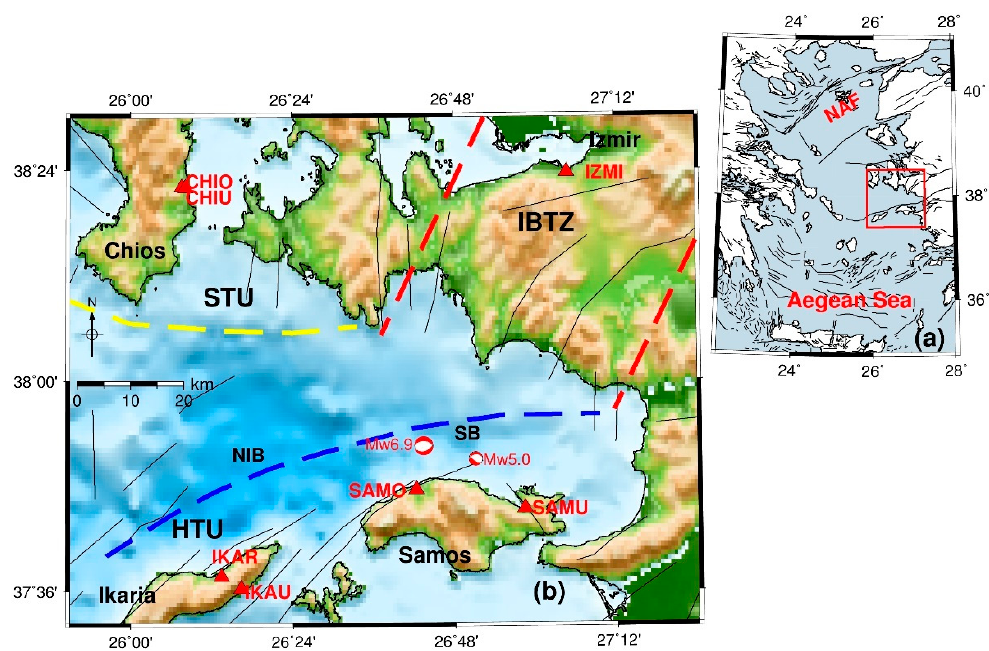
Figure 1. ( a ) Index map and ( b ) relief map of the broader area of Samos, which shows the location of continuous Global Navigation Satellite System (GNSS) sites that were used in this study (red triangles), together with the focal mechanism solutions of the Mw6.9 earthquake and its major aftershock. Faults (black lines) were taken from [15–18]. Red dashed lines define the Izmir Balikesir Transfer Zone (IBTZ); yellow dashed line marks the Sakarya Tectonic Unit (STU); blue dashed line defines the Hellenides Tectonic Unit (HTU); NIB: North Ikaria Basin; SB: Samos Basin; NAF: North Anatolian Fault zone.